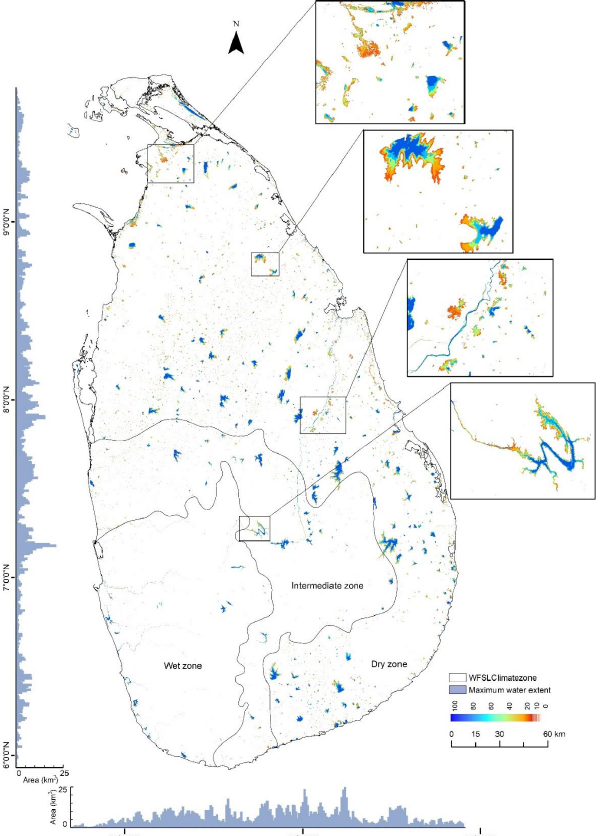
Figure 3. Water occurrence frequencies in Sri Lanka for the whole time-series (December 1987– Figure3. WateroccurrencefrequenciesinSriLankaforthewholetime-series(December1987–November November 2019), its zoom-in views, and maximum water profile with 1 km North/East. 2019), its zoom-in views, and maximum water profile with 1 km North /